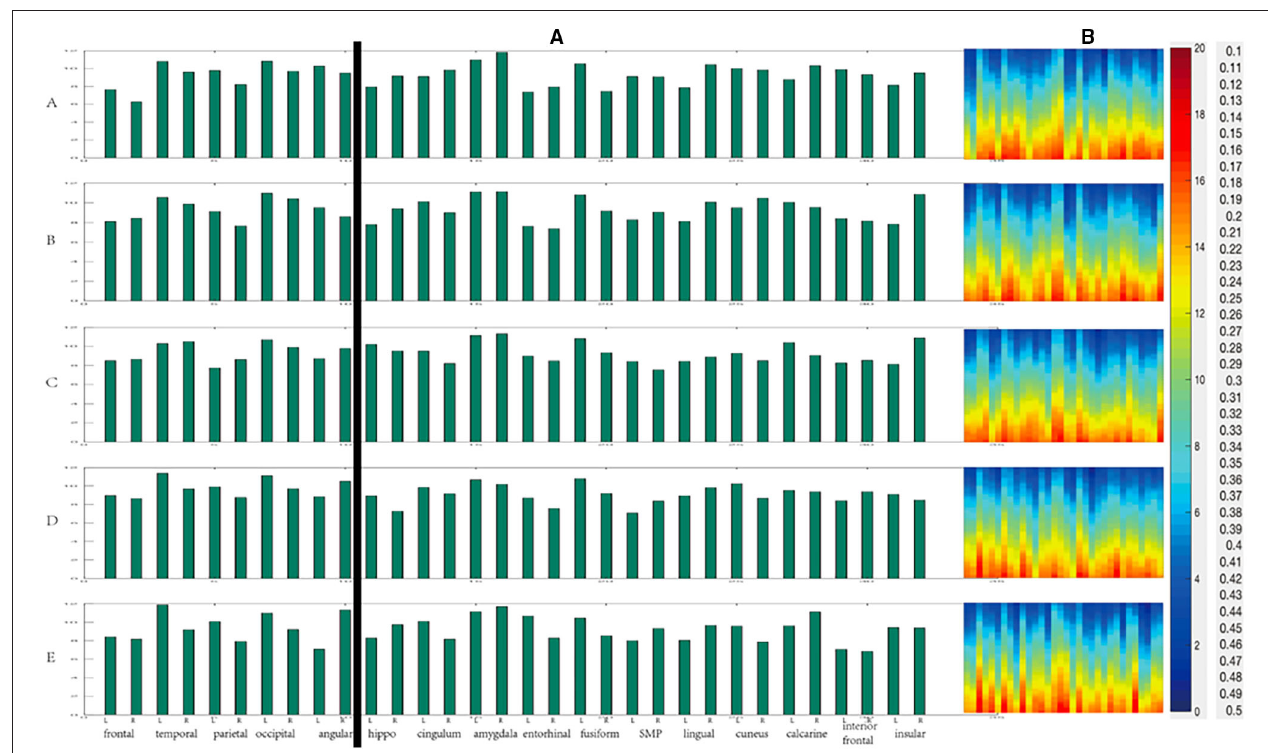
FIGURE 10 | The change of degree during anesthesia recovery [ (A) the histogram of average degree values of each region; (B) The degree values of different